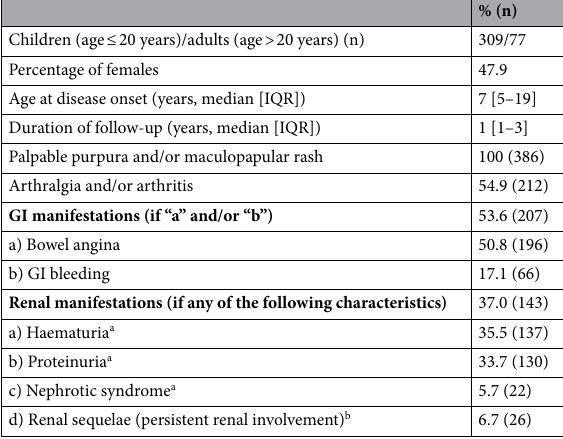
Table 1. Main clinical features of the 386 patients with IgAV included in the study. IgAV: IgA vasculitis; IQR: interquartile range; GI: gastrointestinal. a At any time over the clinical course of the disease. b At last